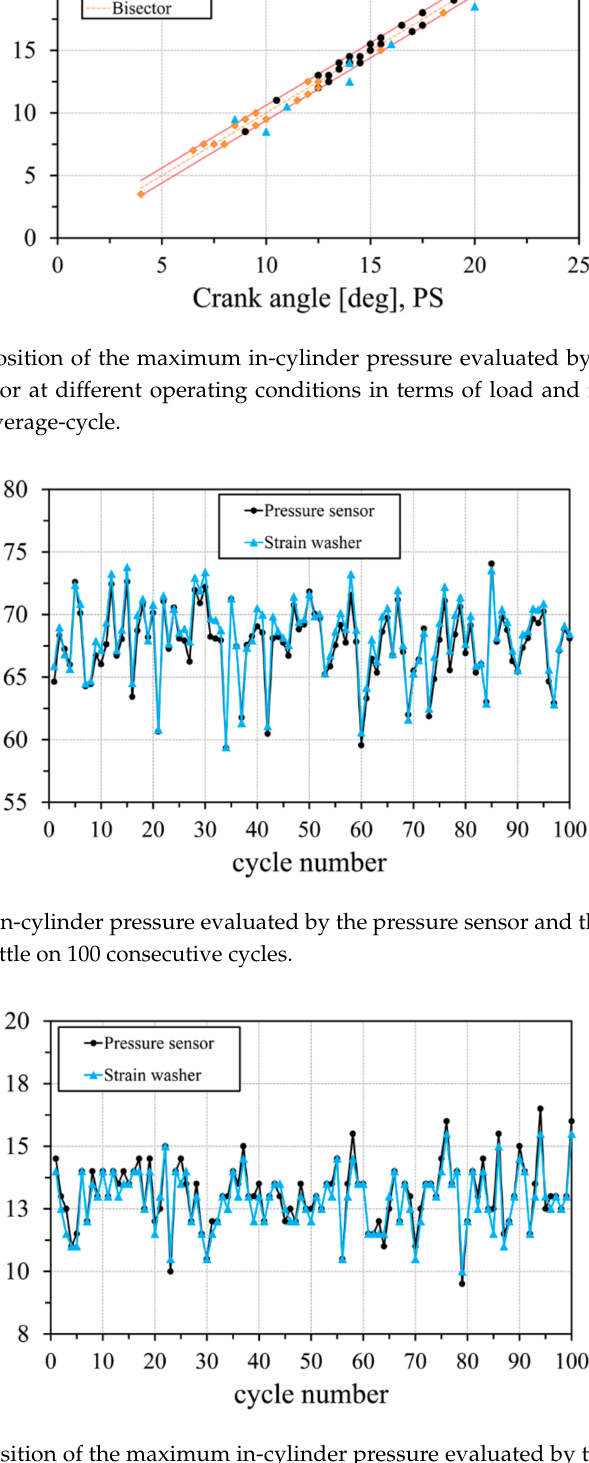
Figure 12. Angular position of the maximum in-cylinder pressure evaluated by the pressure sensor and the strain washer at 4500 rpm and full throttle on 100 consecutive